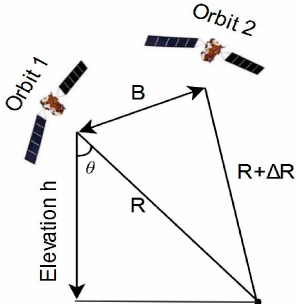
Figure 1. The interferometric phase difference ∆ ϕ is proportional to distance difference ∆ R divided by the transmitted wavelength λ . The B is the baseline and θ is the incidence